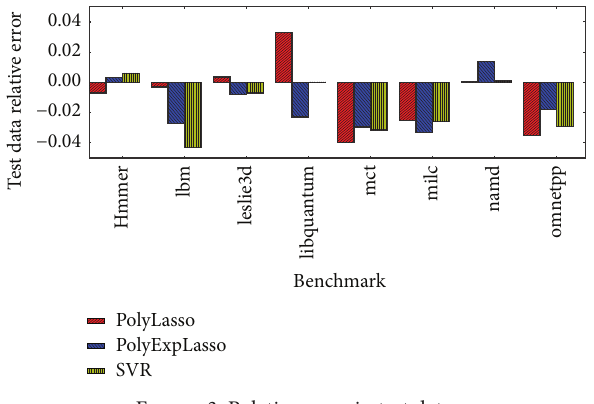
Figure 3: Relative error in test data.